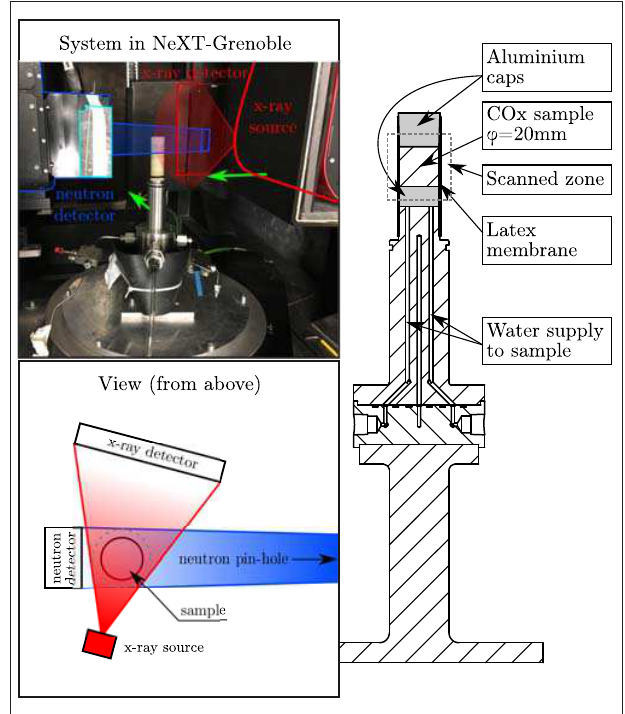
FIGURE 1 | Design of experimental used in this work. Left: photo of setup set up on NeXT-Grenoble scanner, with the sample set up on pedestal. Right: illustrative top view (scales and angles not exact) showing the dual-modality scanning setup on NeXT-Grenoble.